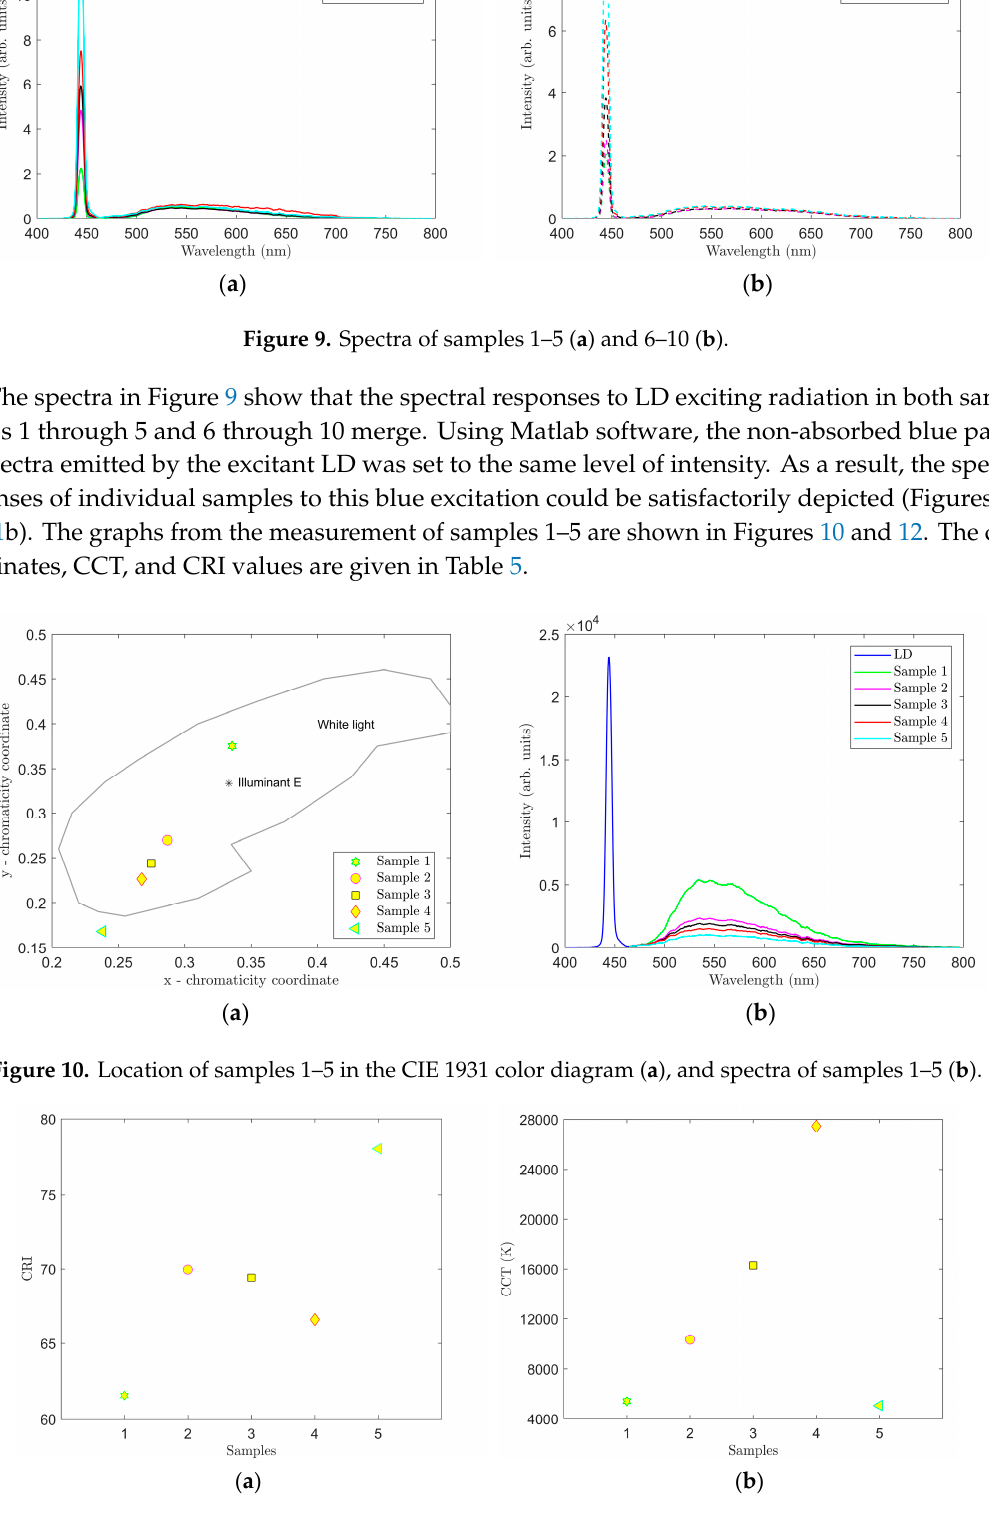
Figure 11. Location of samples 6–10 in the CIE 1931 color diagram ( a ), and spectra of samples 6–10 ( b